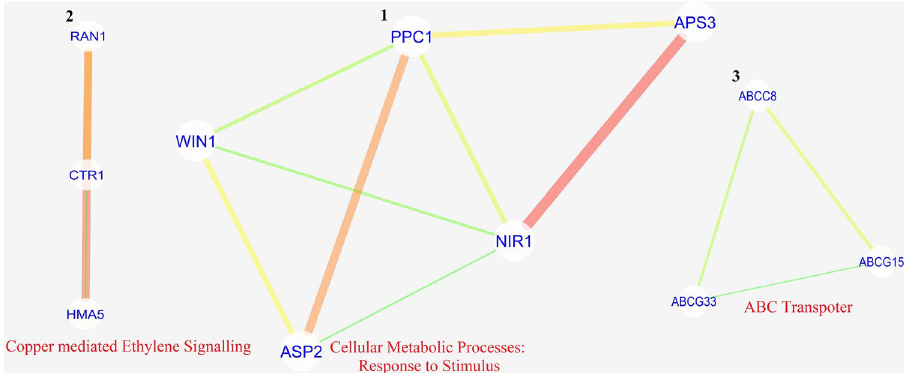
Figure 15. Functional sub-networking of highly interconnected nodes (down-regulated genes) using MCODE (version 2.0.0). Networks were built considering note density and node score cut-off value of 0.1, 0.2 respectively, with kappa-core value of